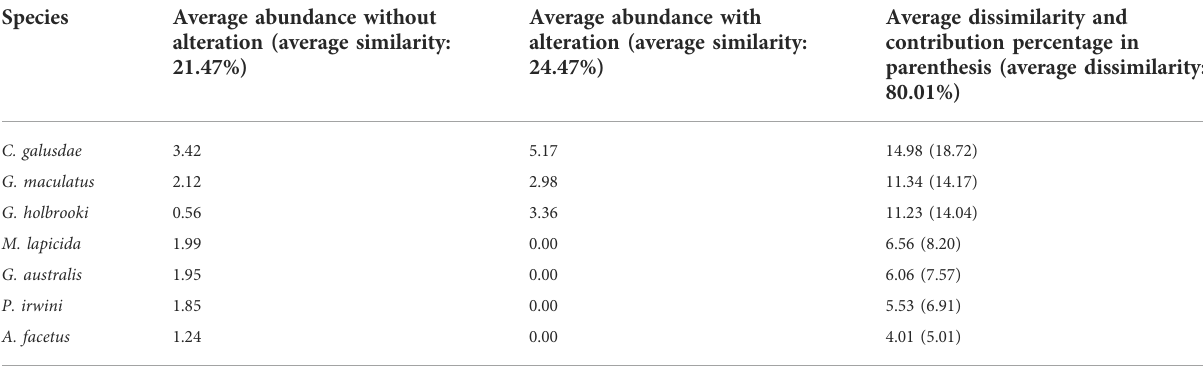
TABLE 3 Similarity percentage analysis (SIMPER) between time periods without direct alteration by dredging (1986 – 2004) and with alteration (2006 – 2018) in the lower area of the Andalién River.